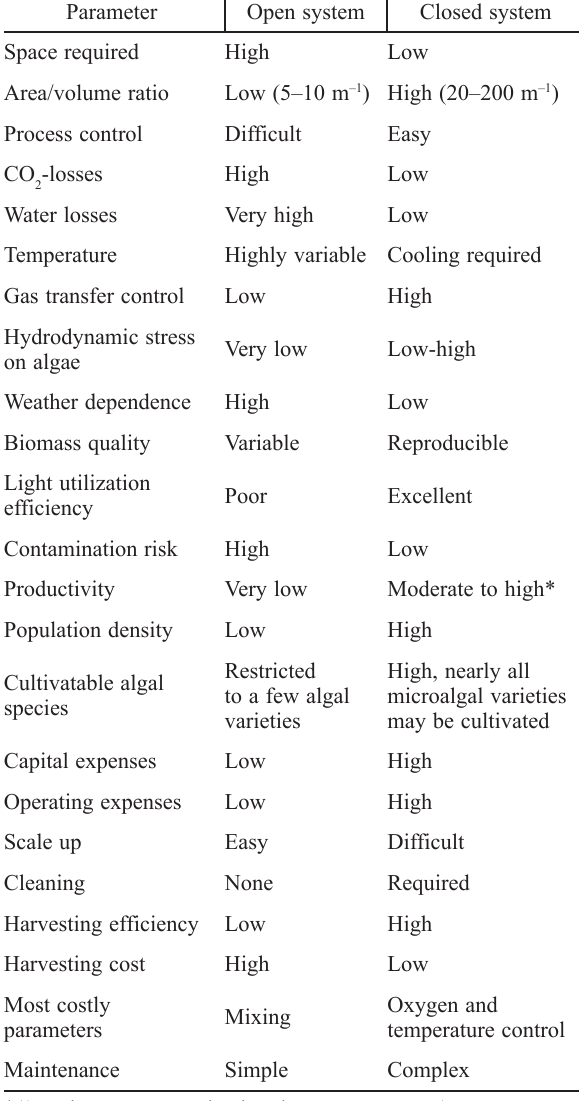
Table 2 – Advantages and disadvantages of open and closed bioreactor systems for microalgae cultivation